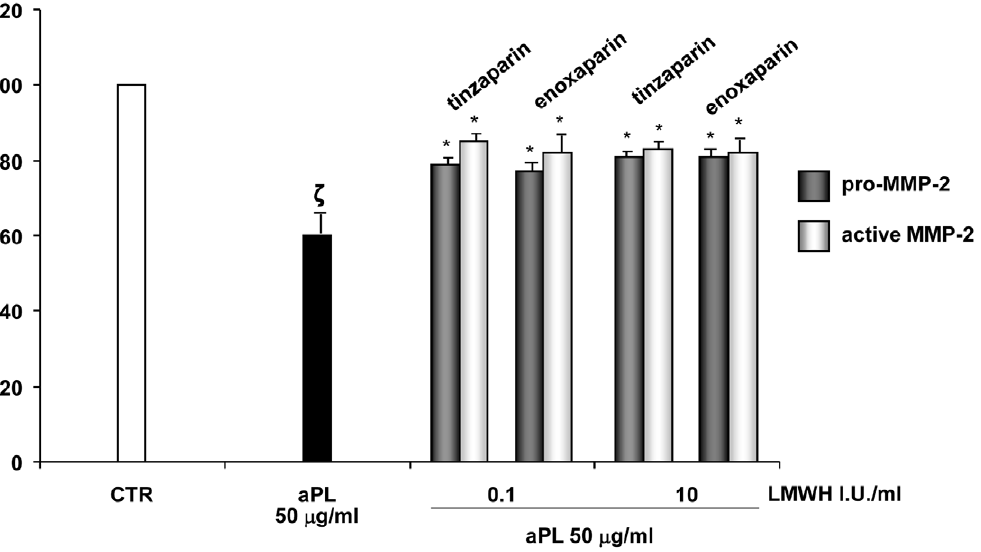
Figure 5. MMP-2 activity evaluation by gelatine zymography. Influence of aPL (50 m g/ml) with or without tinzaparin or enoxaparin treatment on pro-MMP-2 and active MMP-2 gelatinolytic capacity in the supernatant of HEEC. Results are means 6 SE from five experiments and expressed as % of control (CTR). CTR: untreated cells; O.D.: Optical Density; I.U.: International Units; f : P , 0.05 compared with CTR; *: P , 0.05 versus aPL treatment. doi:10.1371/journal.pone.0029660.g005 PLoS ONE |